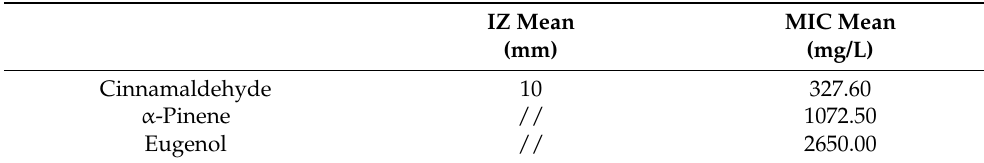
Table 5. Inhibition zones and MICs of cinnamaldehyde, α -pinene, and eugenol against L. acidophilus . IZ